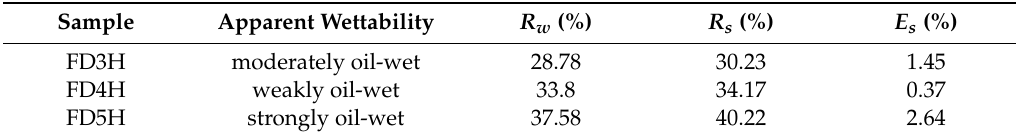
Table 2. The results of flooding experiments.